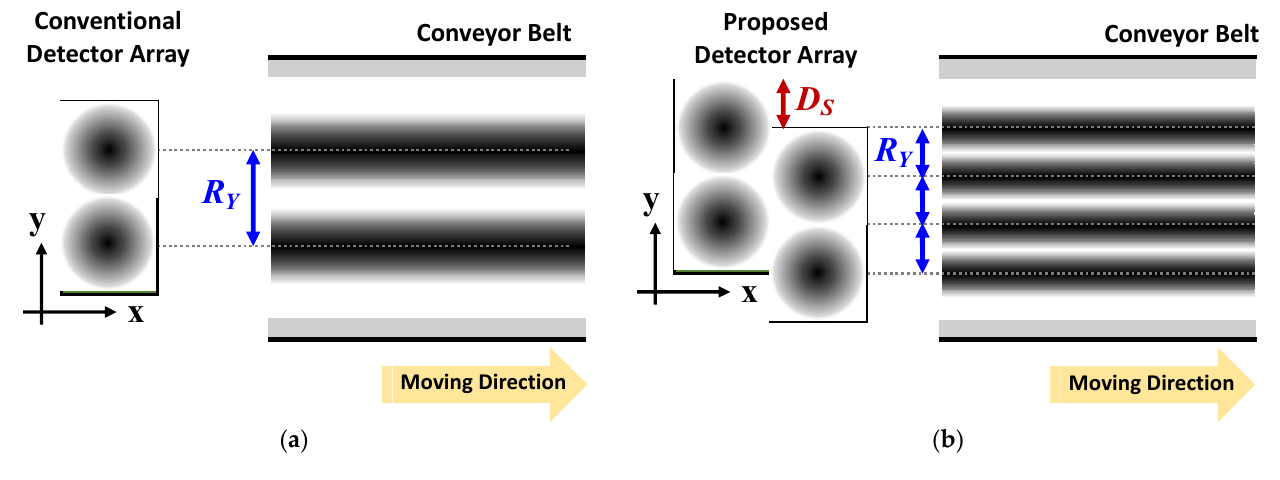
Figure 3. Operating principle to increase the spatial resolution of the proposed detector array: ( a ) Conventional detector array in which the detector unit pixels are linearly arranged. ( b ) Proposed detector array consisting of two columns of detectors that are staggered.